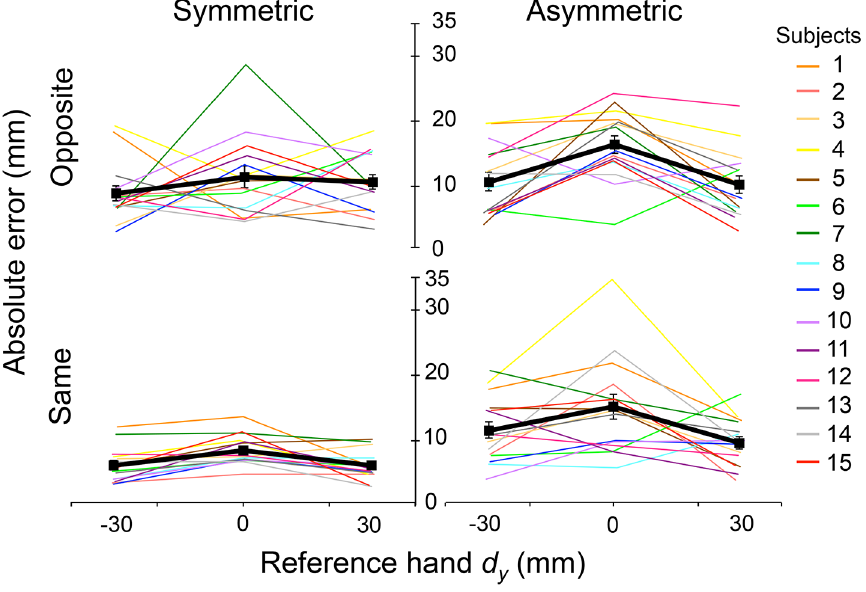
Figure 3. Absolute error: individual subjects. Averages of absolute error of 5 trials from all subjects are shown as a function of reference hand d y ( + 30, 0, and 2 30 mm) for the four matching conditions, and connected with different colors for each subject. The thick black line denotes the mean absolute error averaged across 15 subjects with standard error of the mean. Top panels show the opposite condition, in which subjects were asked to reproduce d y using the opposite hand after a brief delay. Bottom panels show the same condition, in which subjects used the same hand to reproduce d y after a brief delay. These two conditions are shown separately for the symmetric (left) and asymmetric (right) condition, in which postures of the reference and test hand were congruent and inverse,